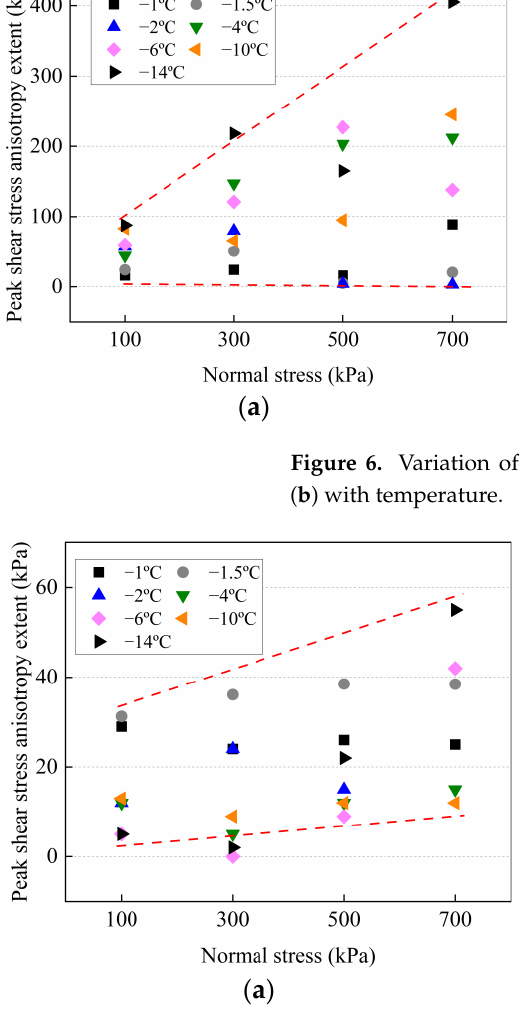
Figure 7. Variation of anisotropy extent of peak shear stress at N = 30. ( a ) With normal stress; ( b ) with temperature.